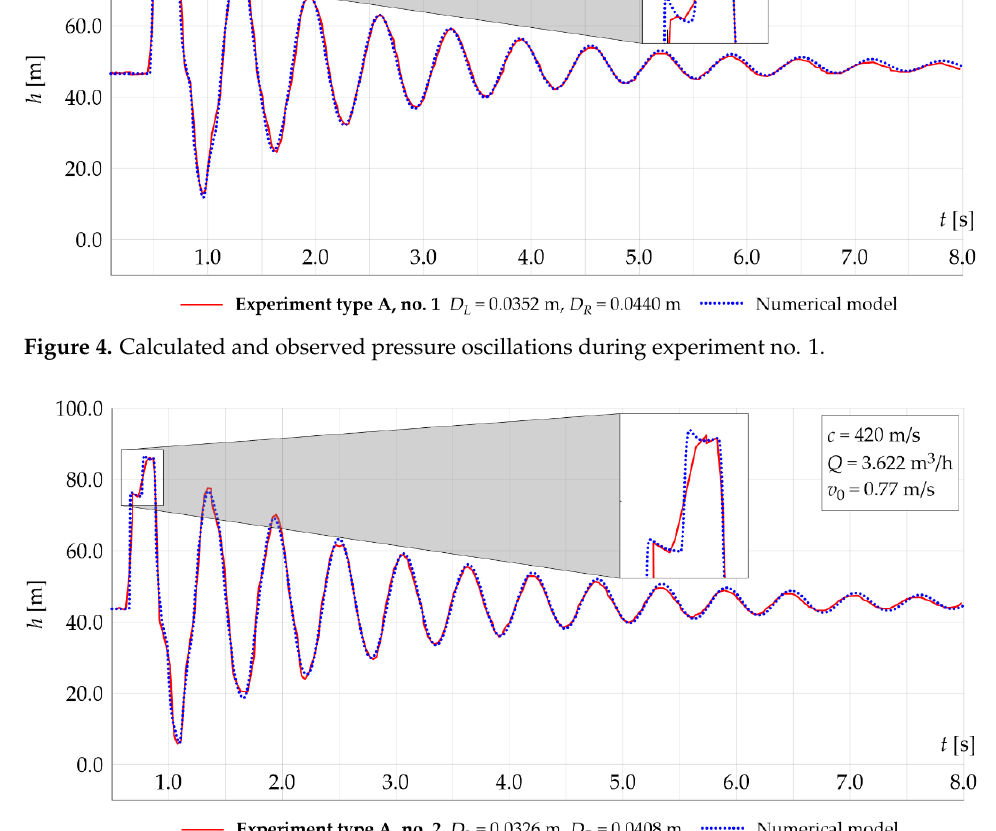
Figure 5. Calculated and observed pressure oscillations during experiment no. 2.